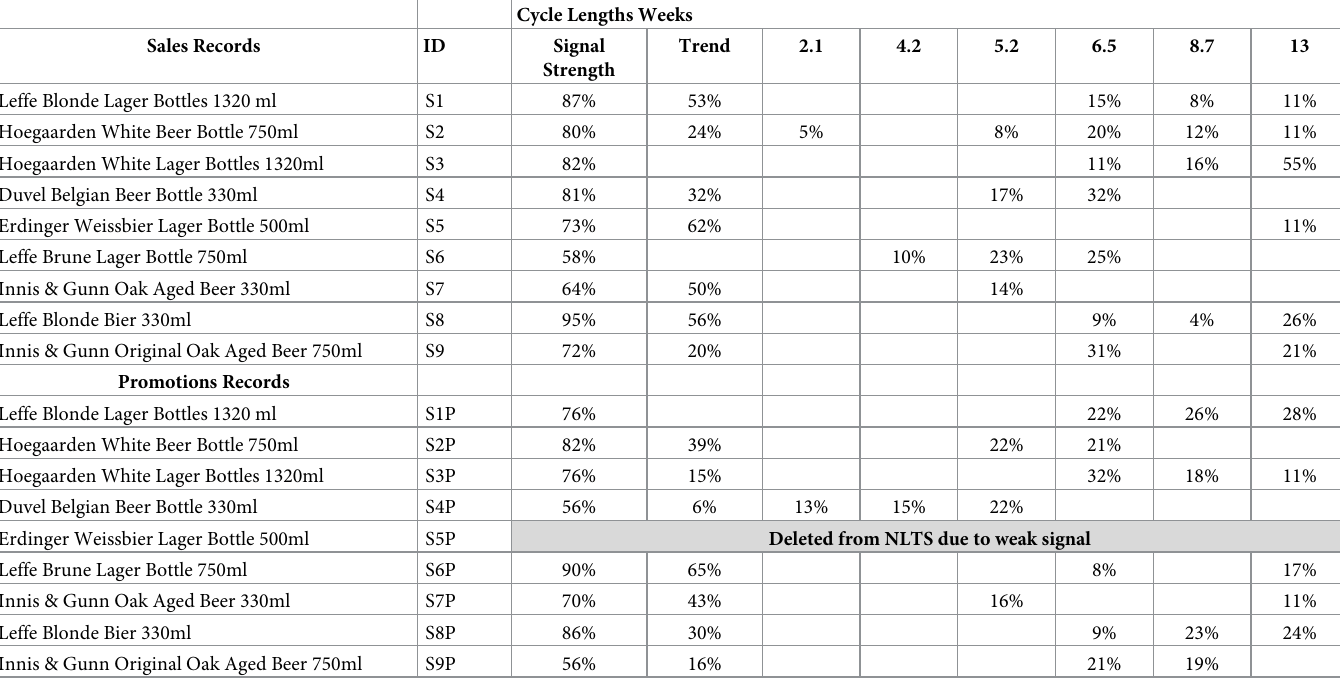
Table 1. Signal processing of weekly category sales and promotions shares.